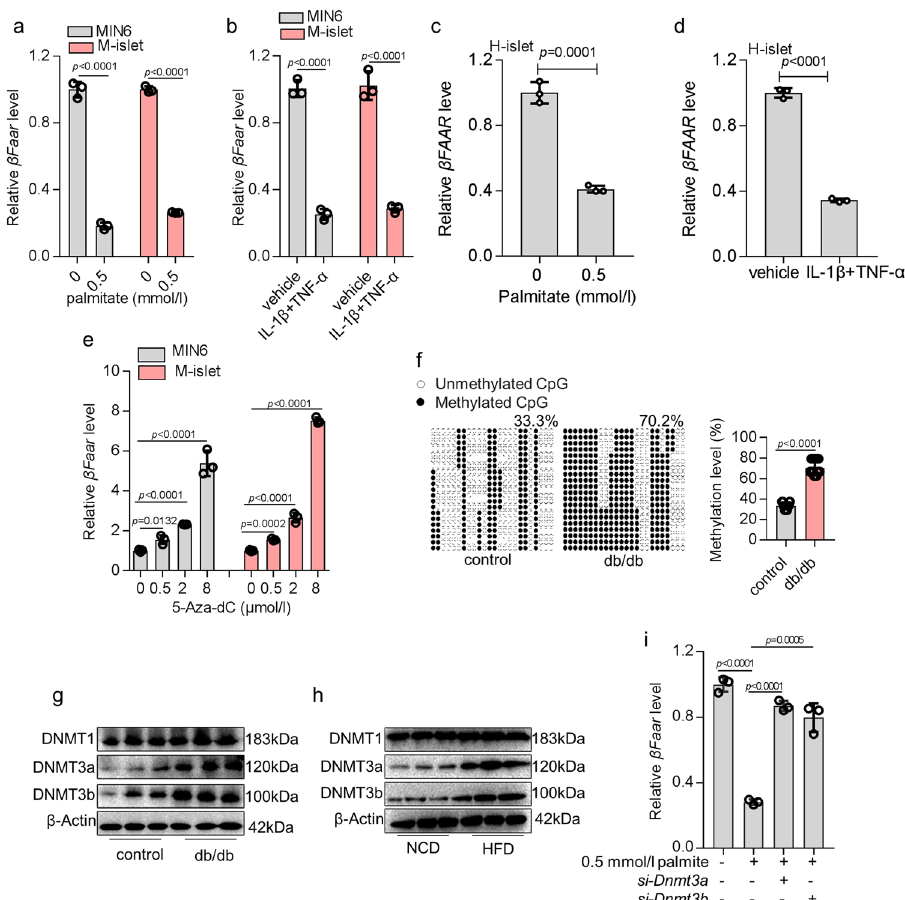
Fig. 2 Obesity-induced reduced expression of β Faar via DNMT3a and DNMT3b. MIN6 cells and mice primary islets were incubated with 0.5 mmol/l palmitate ( a ) and a combination of interleukin-1 β (IL-1 β , 5 ng/ml) and tumor necrosis factor- α (TNF- α , 30 ng/ml, b ) for 48 h and qRT-PCR was